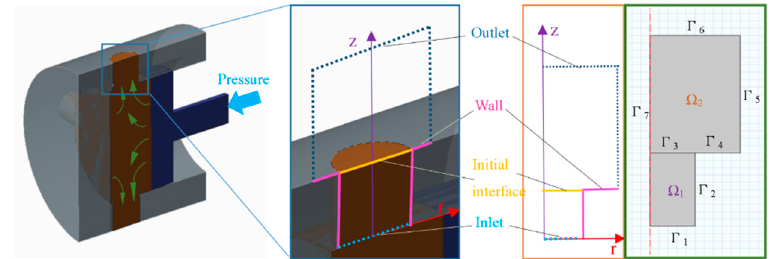
Figure 3. 2D model for simulation of formation of the polymer pattern during extrusion molding.